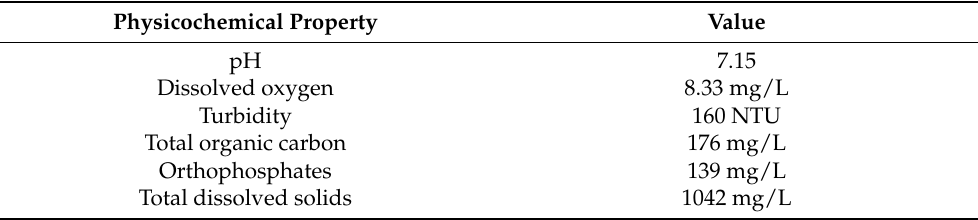
Table 1. Composition of brewery wastewater fresh